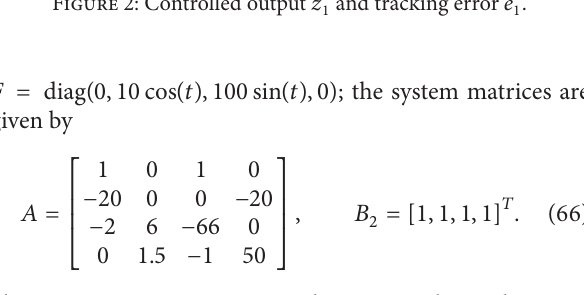
Figure 4: Control input 𝑢 1 .